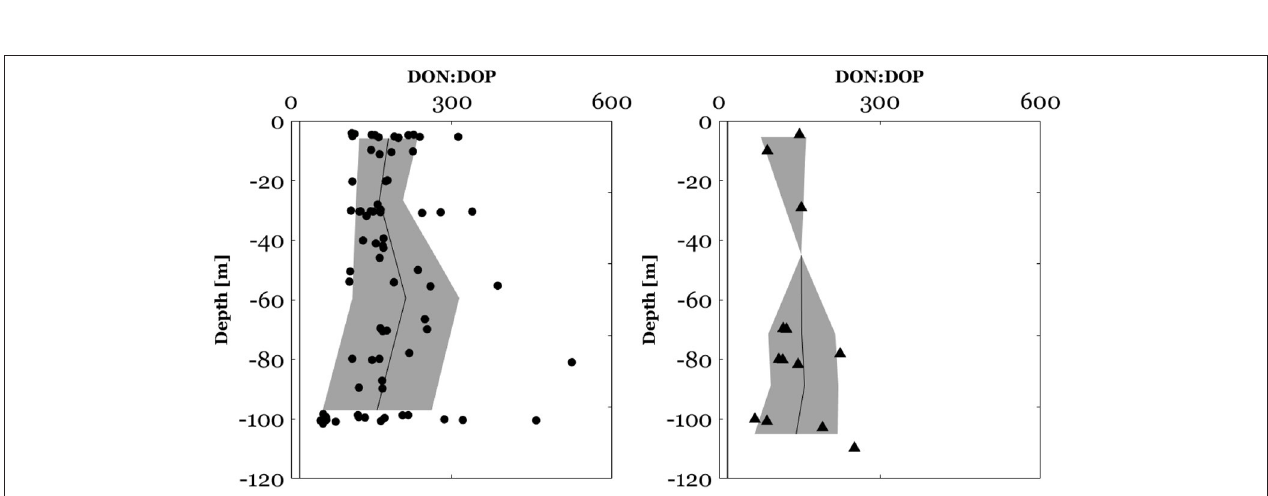
FIGURE 8 | DON:DOP ratios between the surface and 100m in the North Western Mediterranean Sea (circles). DON:DOP molar ratios between the surface and 120m along the E-W transect (triangles) crossing Ionian and Tyrrhenian seas. The black plot represents the mean depth profile of the DON:DOP ratio, the bounded line the standard deviation from the mean and the black vertical line the Redfield molar ratio of